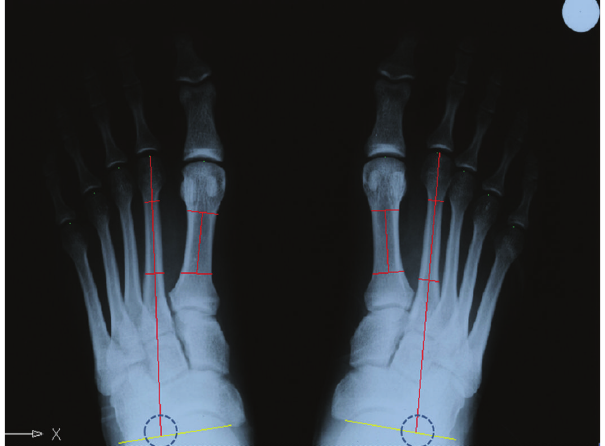
Figure 1: The intersection between the diaphyseal axis of MTT II and the transverse axis of the tarsus was considered as point of rotation to project the tangent to the metatarsal heads.